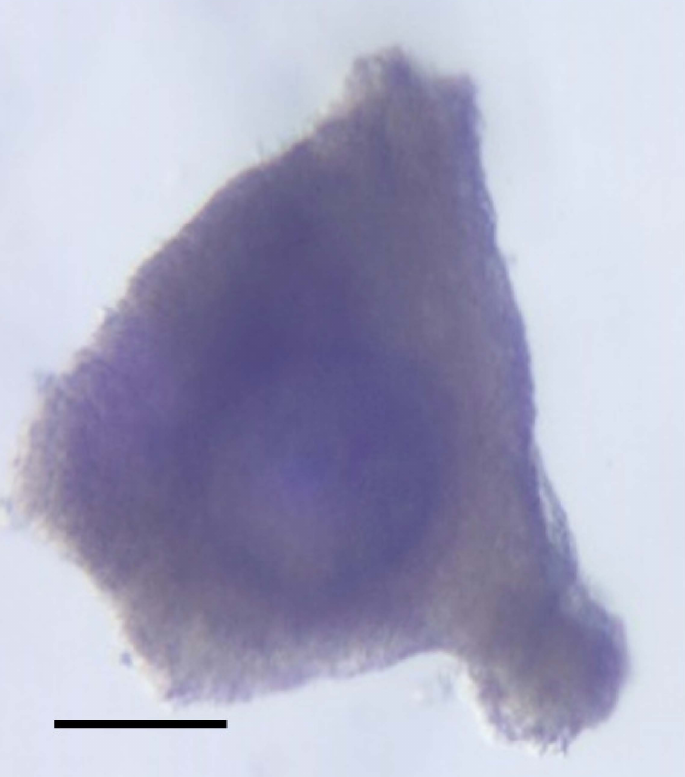
Figure 2. Isolated secondary follicle. Secondary follicles (100–200 µ m) were mechanically dissected, and those with an intact basement membrane and no antral cavity were selected for culture. Scale bar = 100 µ